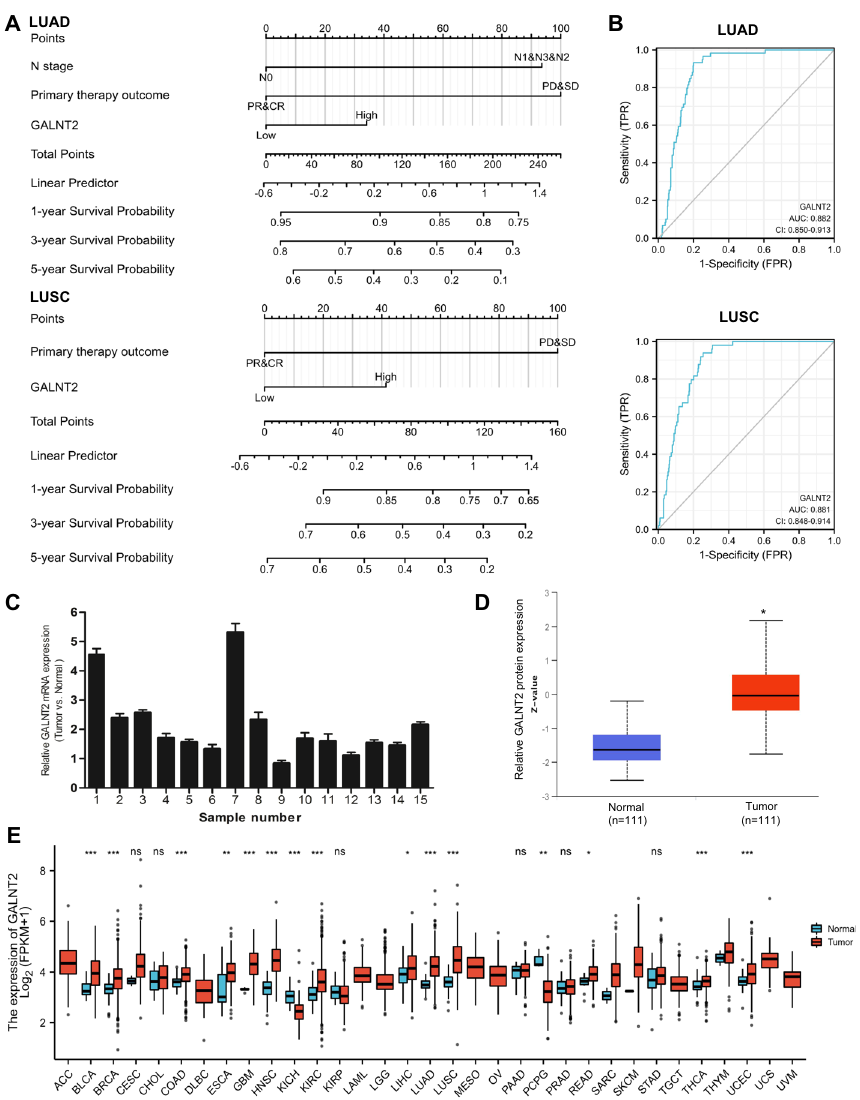
Fig. 3 Clinical significance of GALNT2 in NSCLC. A Nomogram predicting overall survival probability. B ROC curves. C Detection of GALNT2 expression by RT-qPCR in NSCLC tissues. D Analysis of GALNT2 protein expression in NSCLC tissues by UALCAN. E TCGA pan-cancer analysis of GALNT2. NS, no significance; * P < 0.05; ** P < 0.01; *** P <